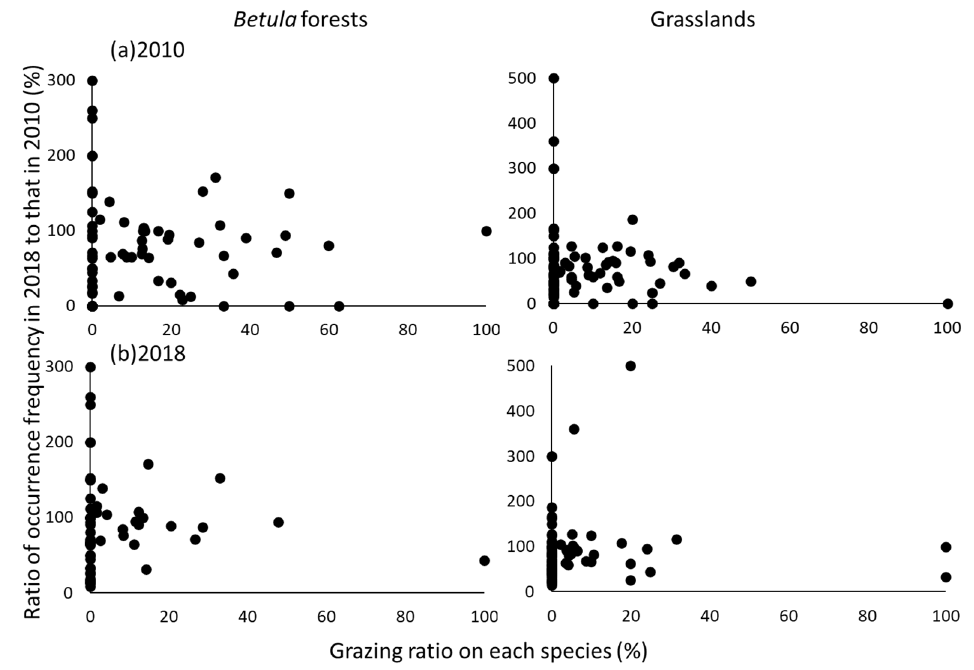
Figure 7. Relationships between grazing ratios (%) on each species in ( a ) 2010 and ( b ) 2018 and ratios (%) of occurrence frequencies in 2018 to those in 2010. The grazing ratios of individual species were not significantly correlated with the changes of the occurrence frequencies of those species between censuses.